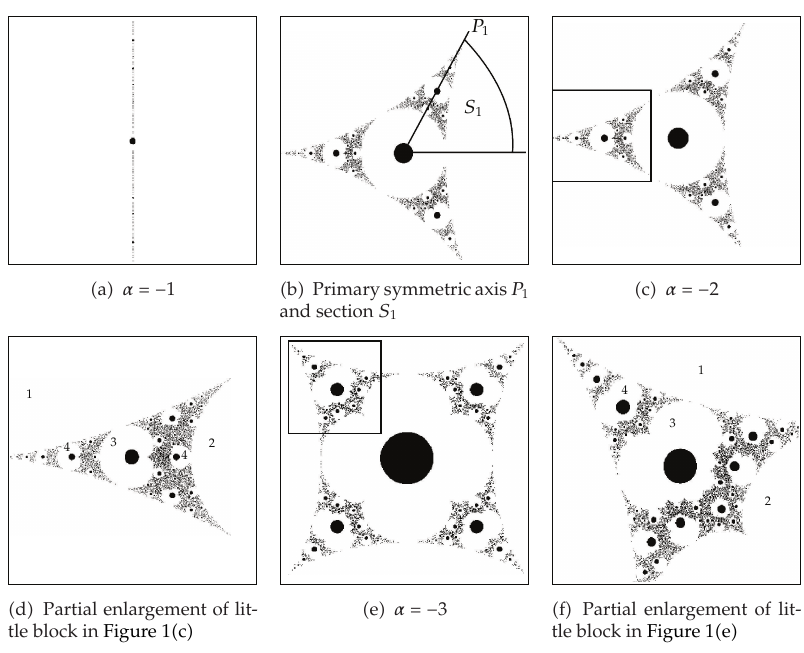
Figure 1: General M-sets and their periodic